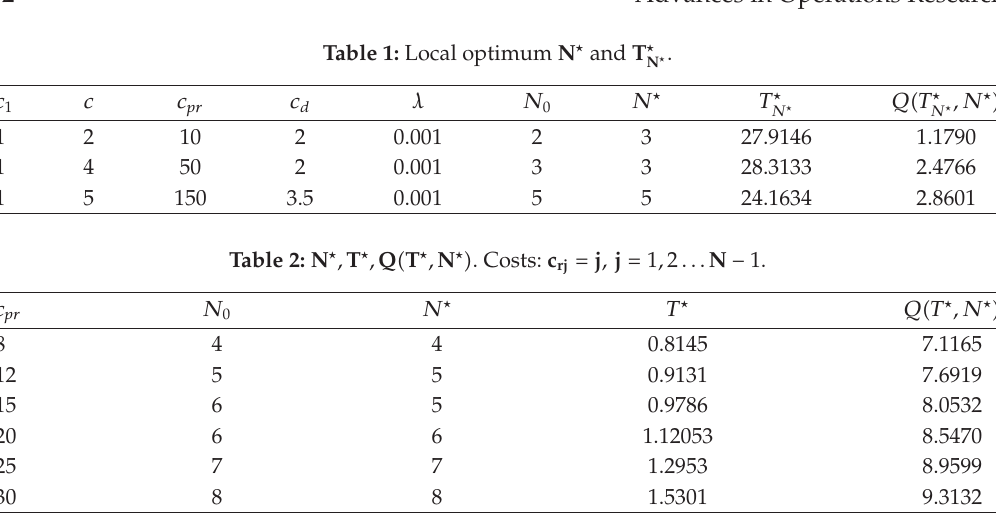
Table 1: Local optimum N (cid:4) and T (cid:4)